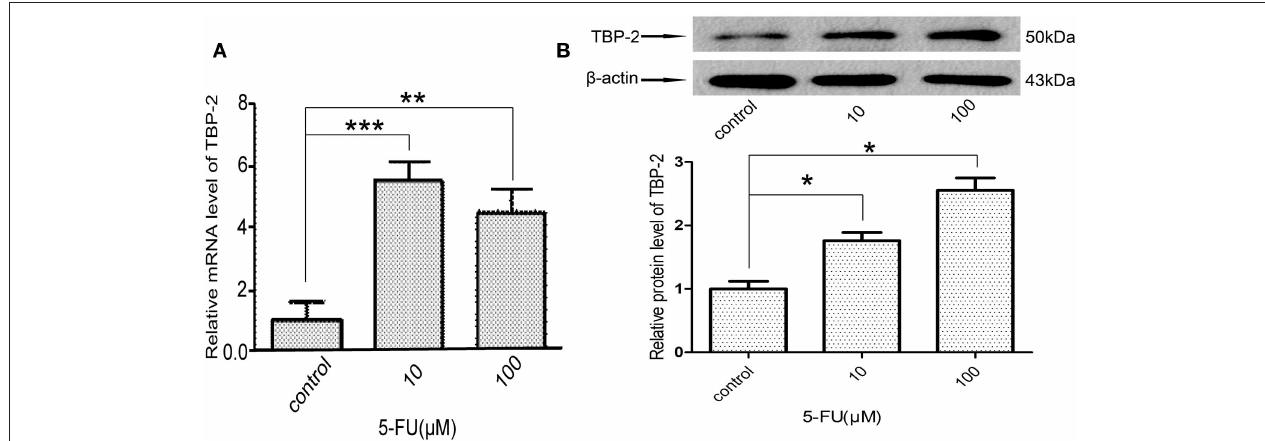
FIGURE 5 | 5-FU induced the expression of TBP-2 in NCI-H460 cells. (A) The mRNA level of TBP-2 was higher in 5-FU-treated cells than control group cells (10 µ M, *** P < 0.001, 100 µ M, ** P < 0.01, Bonferroni’s multiple comparisons test). (B) The protein level of TBP-2 was higher in 5-FU-treated cells than control group cells (10 µ M, * P < 0.05, 100 µ M, * P < 0.05, Bonferroni’s multiple comparisons